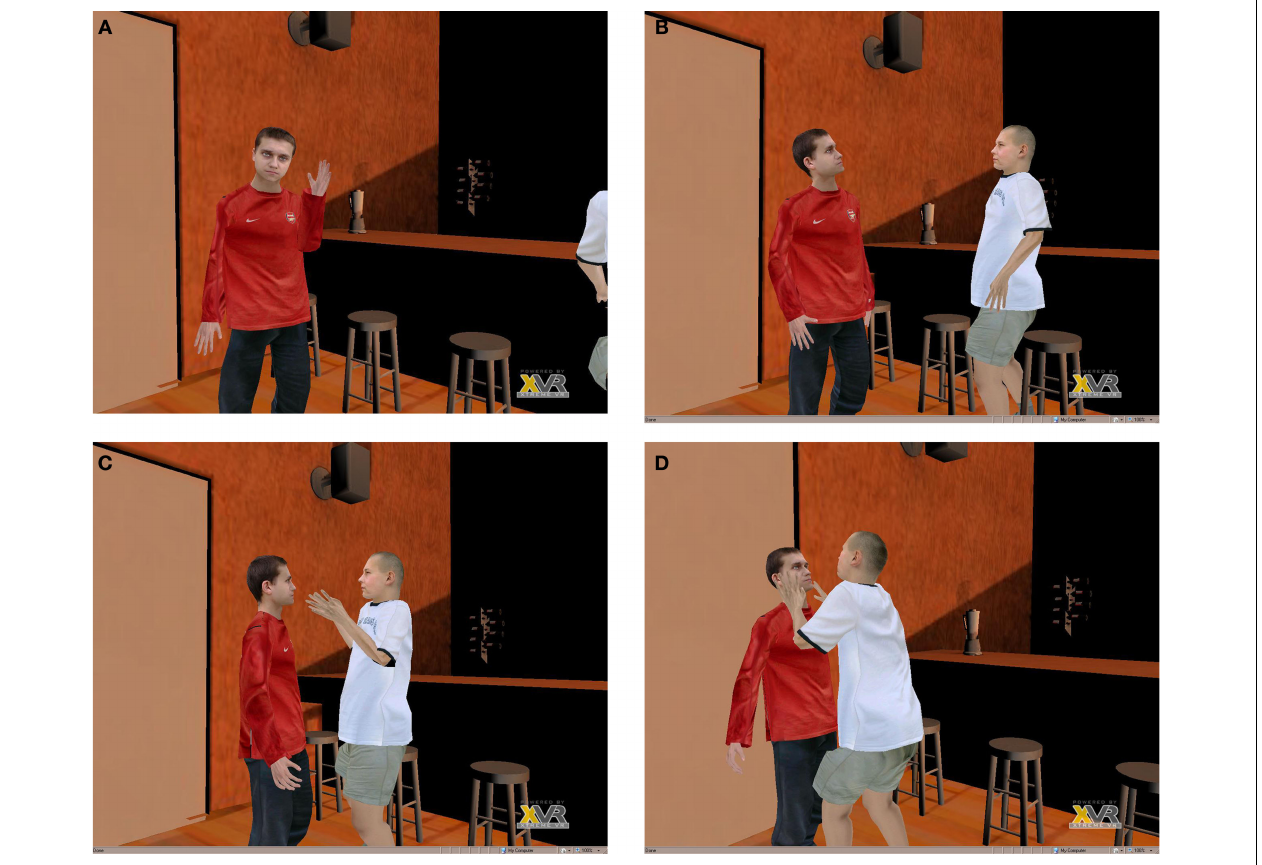
FIGURE 2 | The confrontation in the virtual bar from the viewpoint of the volunteer – (A) the eventual victim fi rst speaks to the volunteer (B) a man previously seated (the eventual perpetrator) approaches the victim (C) the perpetrator acts aggressively towards the victim (D) eventually pushing him violently against the